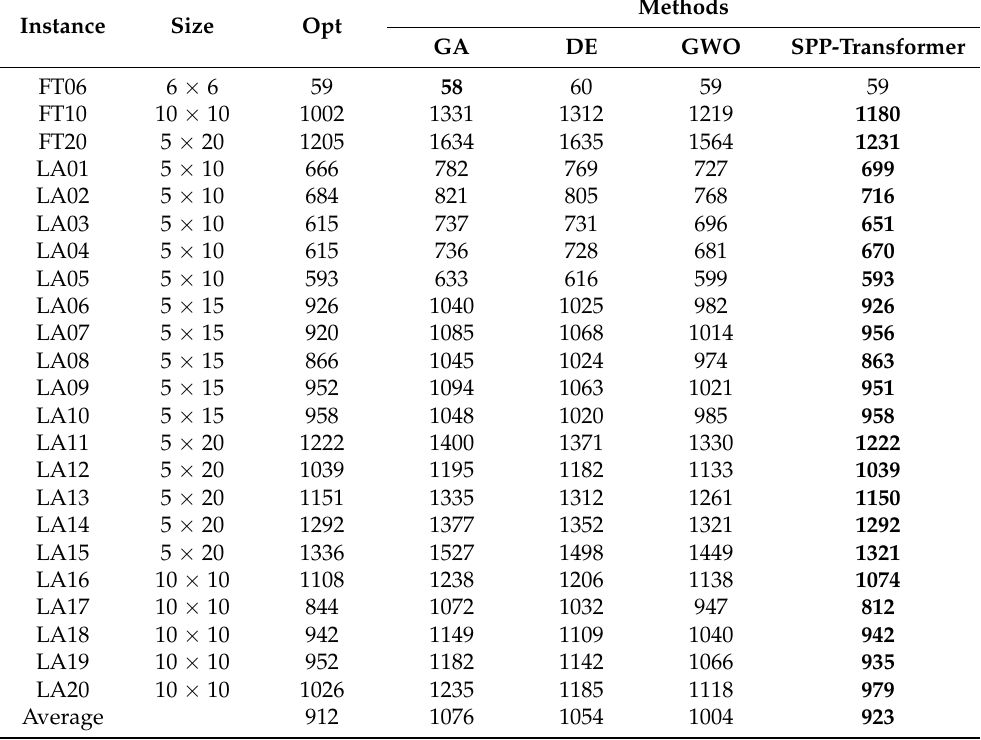
Table A5. The comparison between meta-heuristic methods and SPP-Transformer on